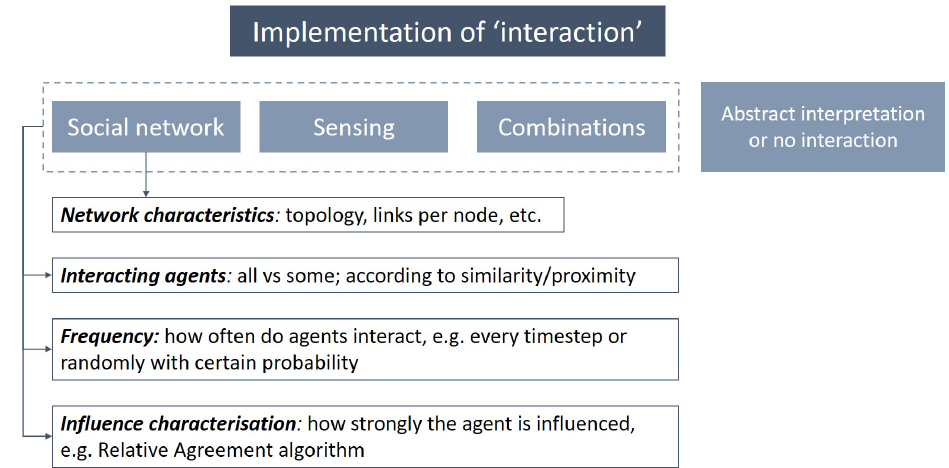
Figure 6. Ways of implementing ’interactions’ and relevant modelling